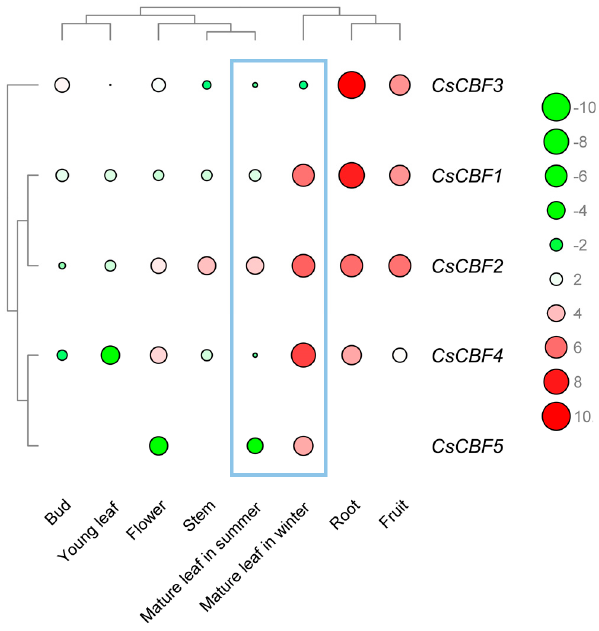
Figure 3. Expression of CsCBF genes in eight tea plant tissues. The bar color represents the normalized FPKM values, green for low expression, red for high expression, and no expression for null. Circle sizes represent the levels of expression. The blue box represents that the expression level of the CsCBF genes is substantially different between mature leaves in winter and mature leaves in summer.